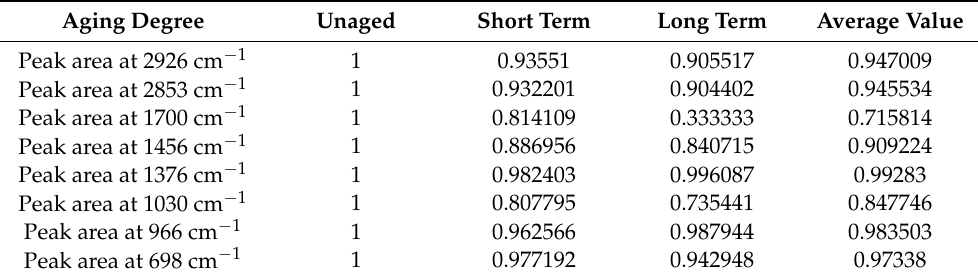
Table 10. Grey correlation degree between W initial and different peak areas (LFSMA-13).